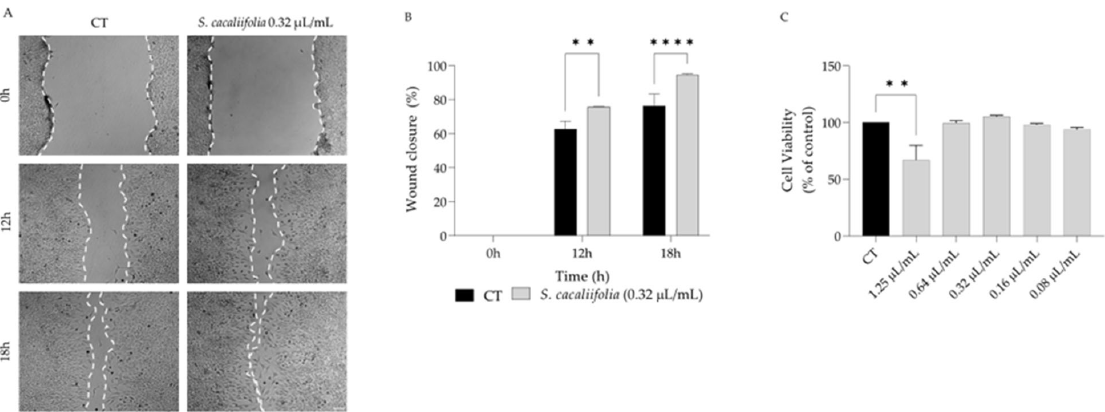
Figure 3. Effect of S. cacaliifolia on wound healing scratch assay. ( A ) Representative phase ‐ contrast images of NIH 3T3 fibroblasts in the presence or absence of S. cacaliifolia essential oil (0.32 μ L/mL) at 0 h, 12 h and 18 h post ‐ scratch. ( B ) Quantification of the percentage of closed “wound”. ( C ) Effect of S. cacaliifolia essential oil on NIH 3T3 fibroblast viability. The results show the mean ± SEM. ** p < 0.01, **** p < 0.0001 when compared to control (CT) after two ‐ way ANOVA followed by Sydák’s multiple comparison test or one ‐ way ANOVA followed by Dunnett’s multiple comparison test.